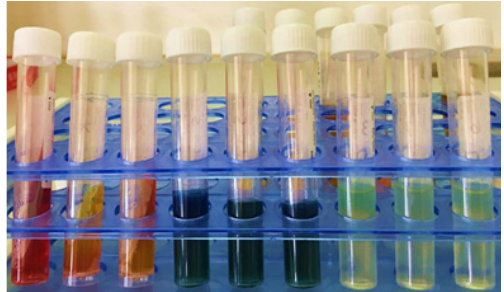
Fig. 2. Biochemical test for Urease +ve isolated bacteria